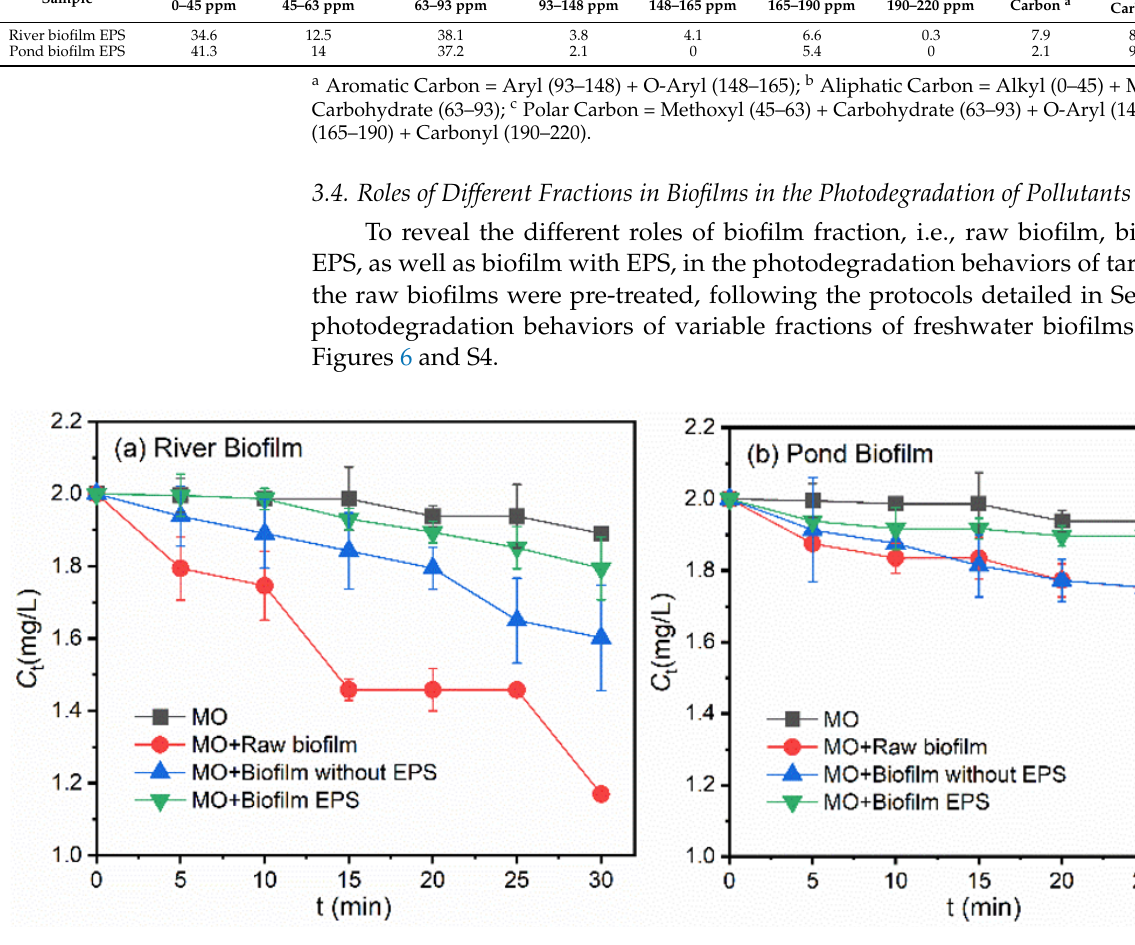
Figure 6. Photodegradation behaviors of MO in the presence of different ( a ) River biofilm fractions and ( b ) Pond biofilm fractions, i.e., raw biofilm with a content of 696 mg/L, the same content of raw biofilm after EPS extraction, as well as the extracted EPS (~14 mgC/L TOC). C 0 [MO] = 2 mg/L.